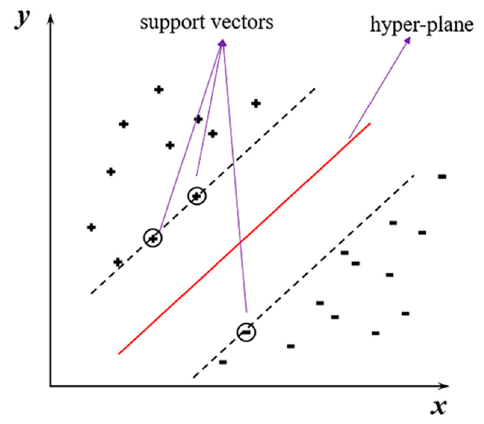
Figure 4. A maximal margin hyperplane with its support vectors circled.